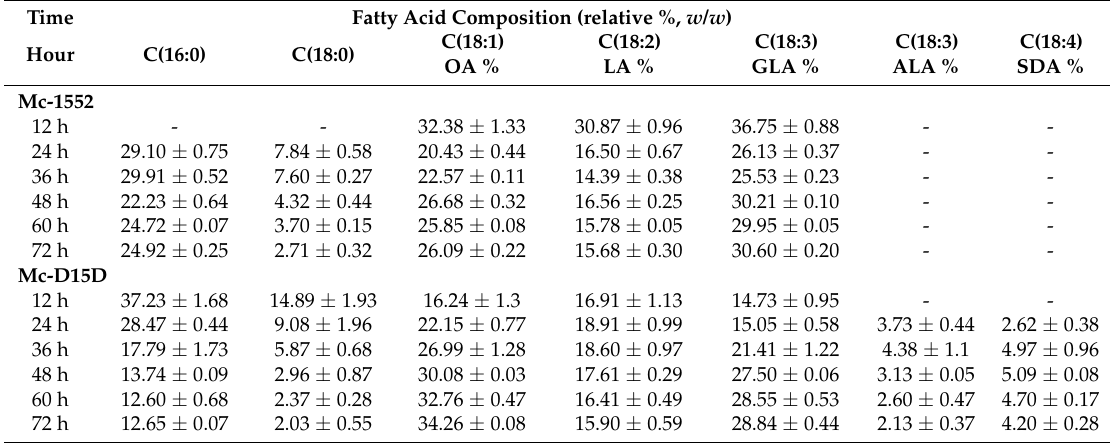
Table 1. The fatty acid composition in D15D overexpressing